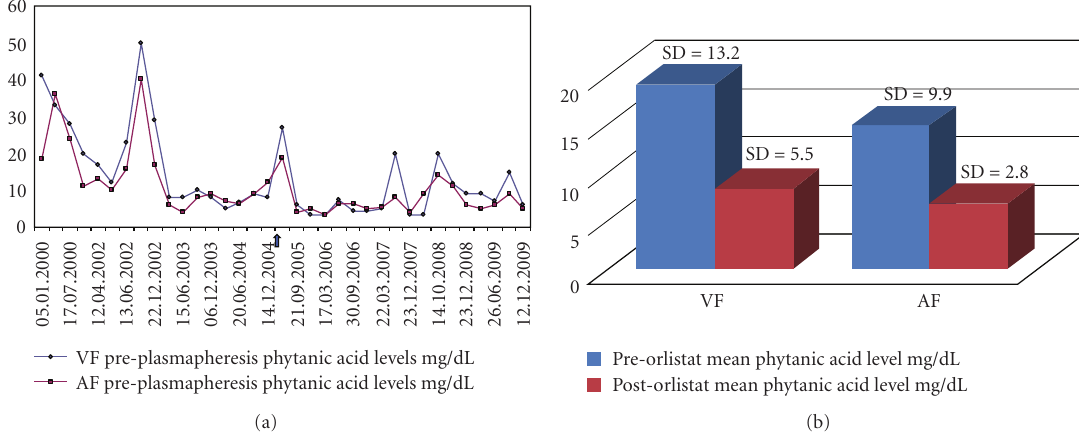
Figure 3: (a) Pre-plasmapheresis plasma phytanate (phytanic acid) levels. AF’s and VF’s preplasmapheresis phytanic acid levels before and after addition of Orlistat (Xenical) therapy to diet and regular plasmapheresis (shown by arrow in June 2005) showing good control of phytanic acid levels except during periods of non compliance with Orlistat therapy (in 2008) and weight loss (in 2007 and 2009). (b) AF’s and VF’s mean plasma phytanic acid levels (mg/dL) before and after addition of Orlistat therapy to regular plasmapheresis and stable low phytanic acid diet. AF’s and VF’s mean phytanic acid level before addition of Orlistat was 14.8 mg/dL (SD 9.9) and 19.0 mg/dL (SD 13.2), respectively. AF’s and VF’s mean phytanic acid level after addition of Orlistat therapy was 6.7 mg/dL(SD 2.8) and 8.2 mg/dL (SD5.5), respectively, with a P -value < 0.05 on two-sample t